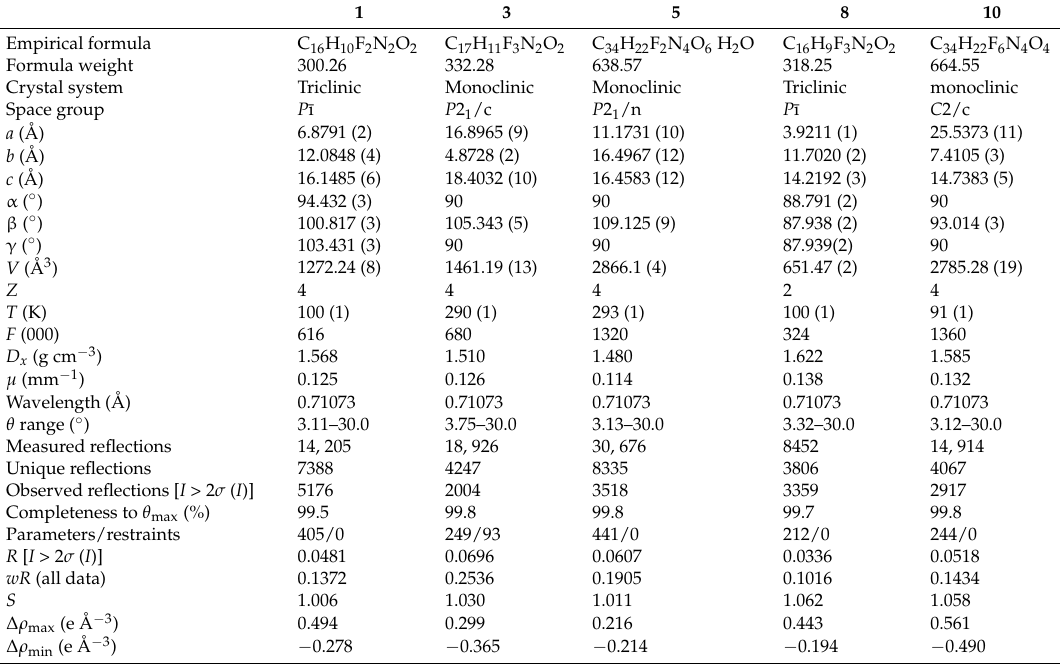
Table 1. Crystallographic data for 1 , 3 , 5 , 8 and 10 .